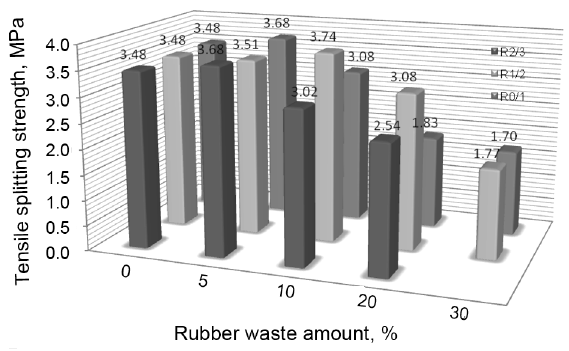
Fig. 9. The change in the splitting tensile strength of concrete